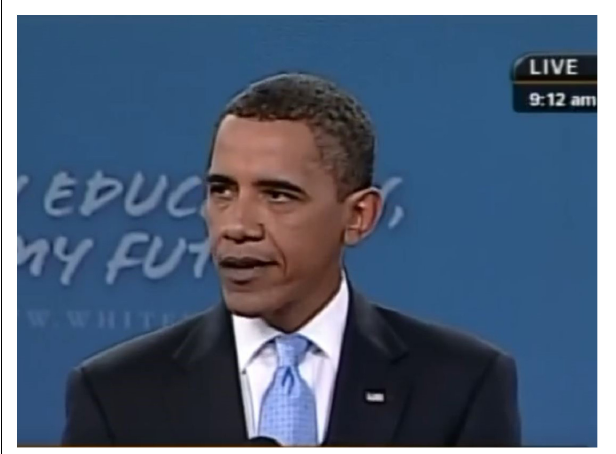
FIGURE 2 | Facial expression of contempt accompanying the speech excerpt in the experimental condition. Screenshot taken from https://obamawhitehouse.archives.gov/copyright. Copyright policy details that pursuant to federal law, government-produced materials appearing on this site are not copyright protected. The United States Government may receive and hold copyrights transferred to it by assignment, bequest, or otherwise. Except where otherwise noted, third-party content on this site is licensed under a Creative Commons Attribution 3.0 License. Visitors to this website agree to grant a non-exclusive, irrevocable, royalty-free license to the rest of the world for their submissions to Whitehouse.gov under the Creative Commons Attribution 3.0